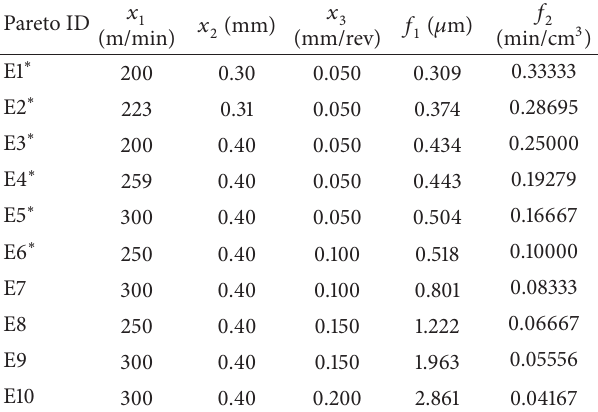
Table 5: Listing of undominated samples from m-EGO.